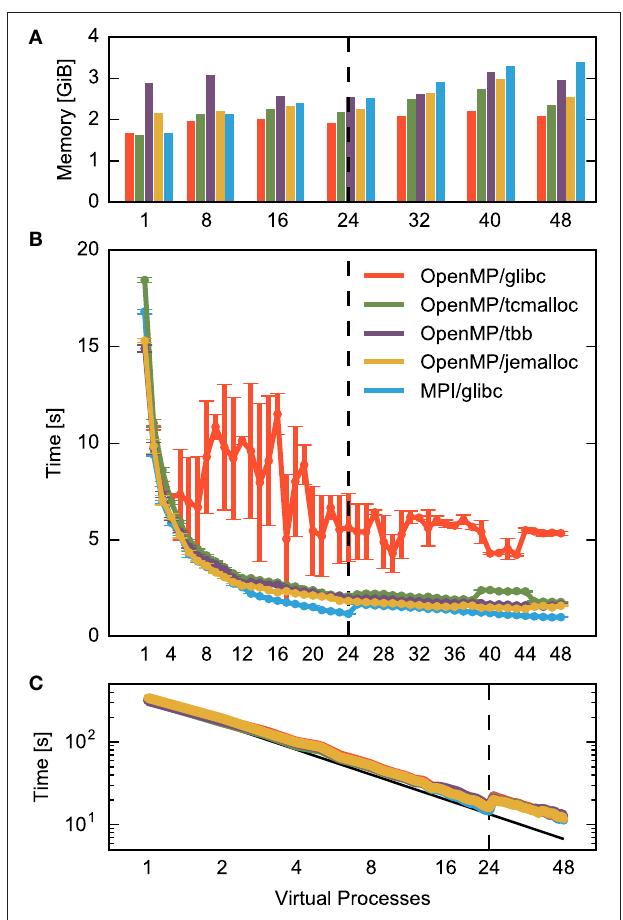
FIGURE 5 | Performance of a small neuronal network model using different memory allocators. (A) Memory consumption after network construction, (B) runtime required for network construction, and (C) runtime for network simulation excluding network construction as a function of the degree of parallelization at constant network size (strong scaling). Data are for the same network model and machine as in Figure 1 . The dashed vertical line in each figure indicates the number of cores available on the compute node. Results obtained with the standard allocator ptmalloc are shown in red (parallelization with OpenMP) and blue (parallelization with MPI) and show the same data as in Figure 1 , while results for alternative allocation algorithms are shown in green (tcmalloc), violet (tbb), and yellow (jemalloc) respectively; see Section 2.4 for detailed specification of allocators. Data in (C) are shown in double-logarithmic representation, with the black line indicating ideal